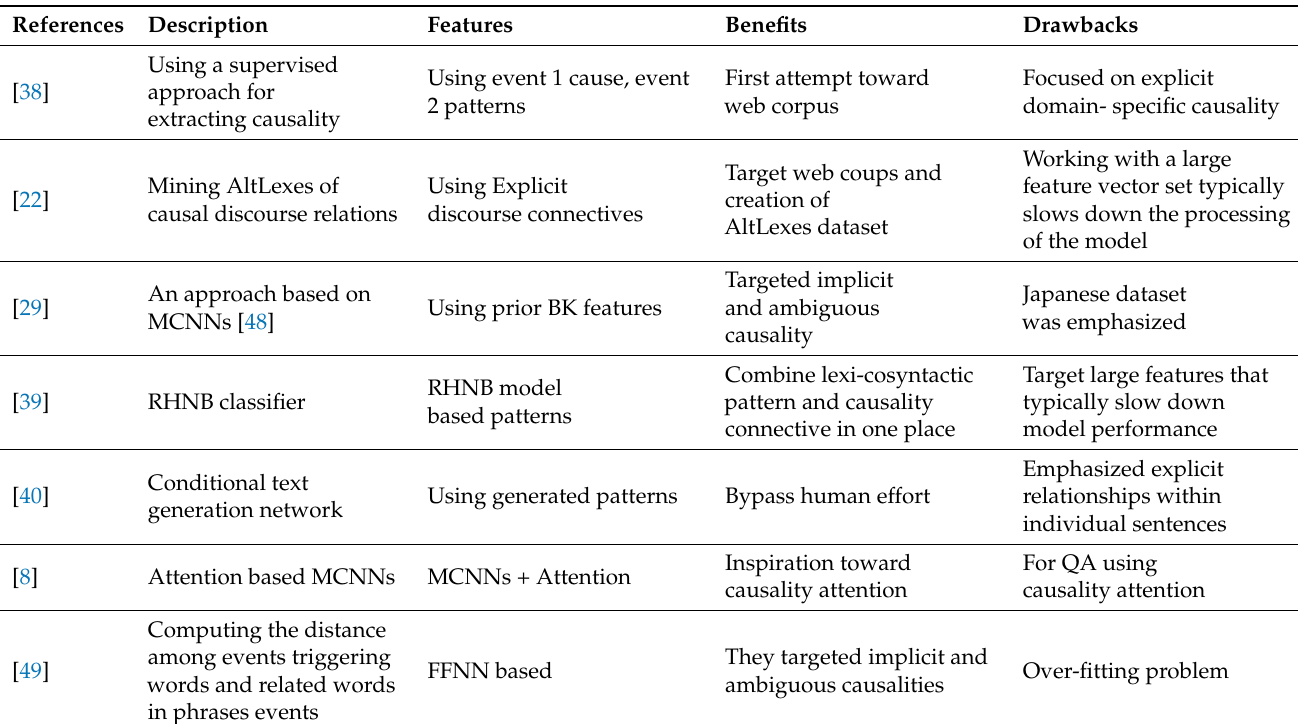
Table 1. A list of related techniques that have been